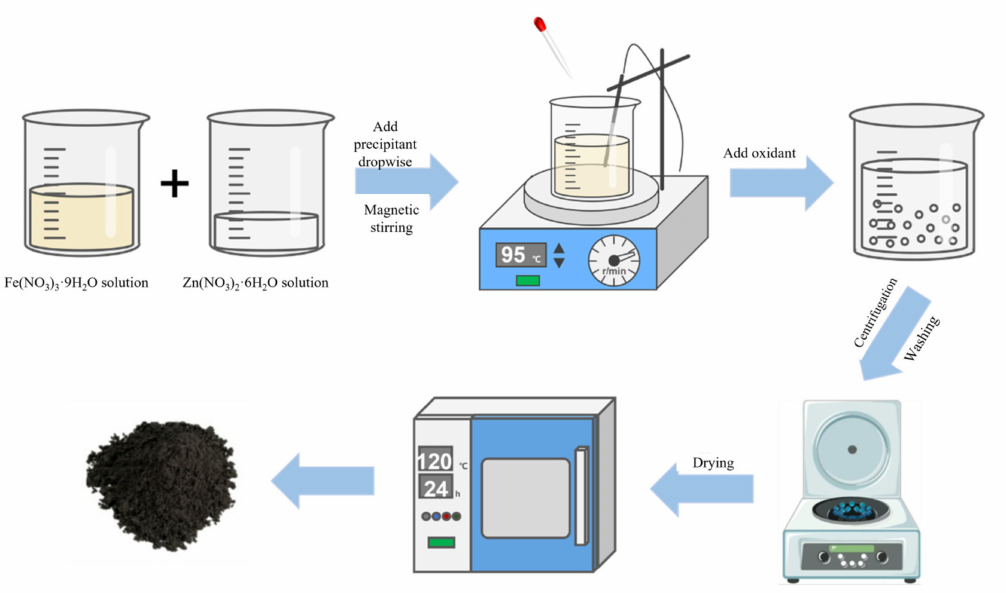
Figure 5. A schematic representation of the general steps used for the co-precipitation technique of ZnFe 2 O 4